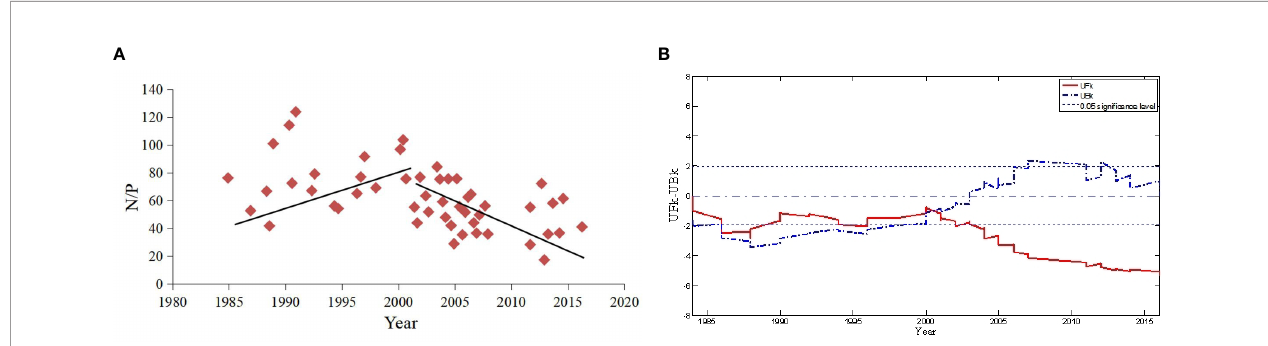
FIGURE 3 | (A) N/P in the mixing zone of the Changjiang River Estuary during 1984 to 2016. (B) N/P change-point analysis of the Changjiang River Estuary during 1984 to 2016.